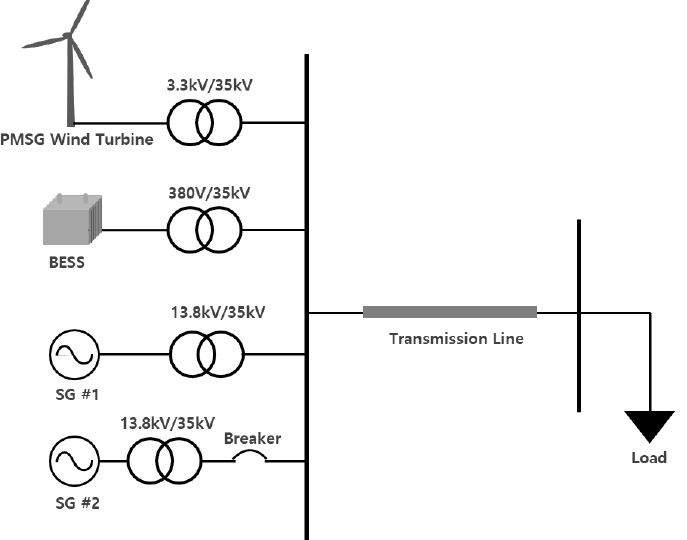
Figure 8. Configuration of the test system.